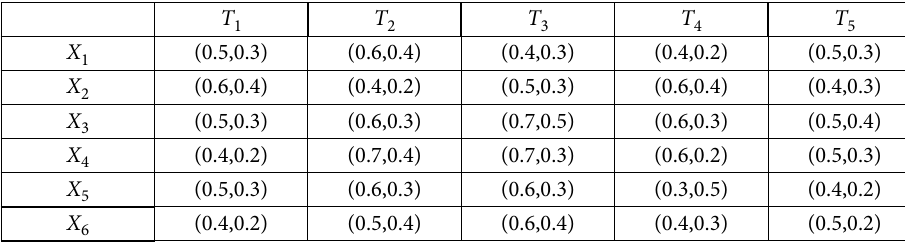
Table 3. Decision matrix with q-ROFNs by the third